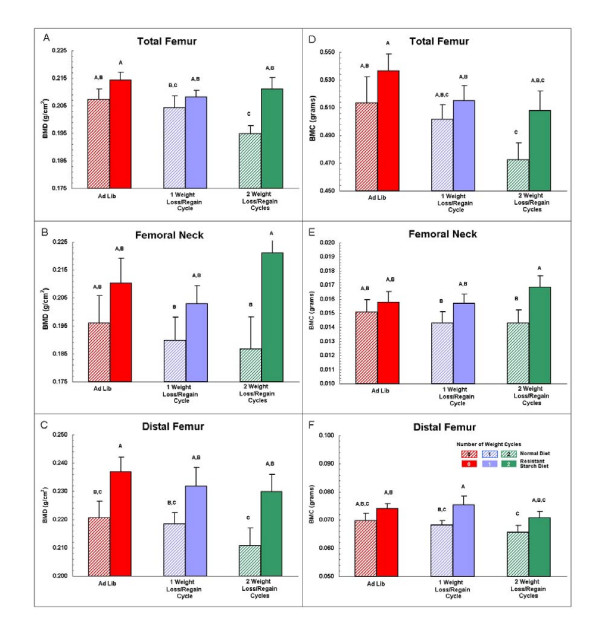
Bone mineral density and bone mineral content. Bone mineral density (BMD) and bone mineral content (BMC) of the total femur, femoral neck, and distal femur for right femurs of rats in the six treatment groups after 21 weeks. N = 84 rats. Each bar in the figure is the mean with standard error for 14 femurs. Mean BMD and BMC are consistently higher for rats fed the diets containing resistant starch (solid bars) than for their counterparts (adjacent striped bars) fed the normal diets. Values not marked with the same upper-case letters (A, B, or C) differ significantly (p < 0.05) by comparison of least-square means. Inferential statistical analyses of these data by 2-way ANOVA are provided in Table 3.